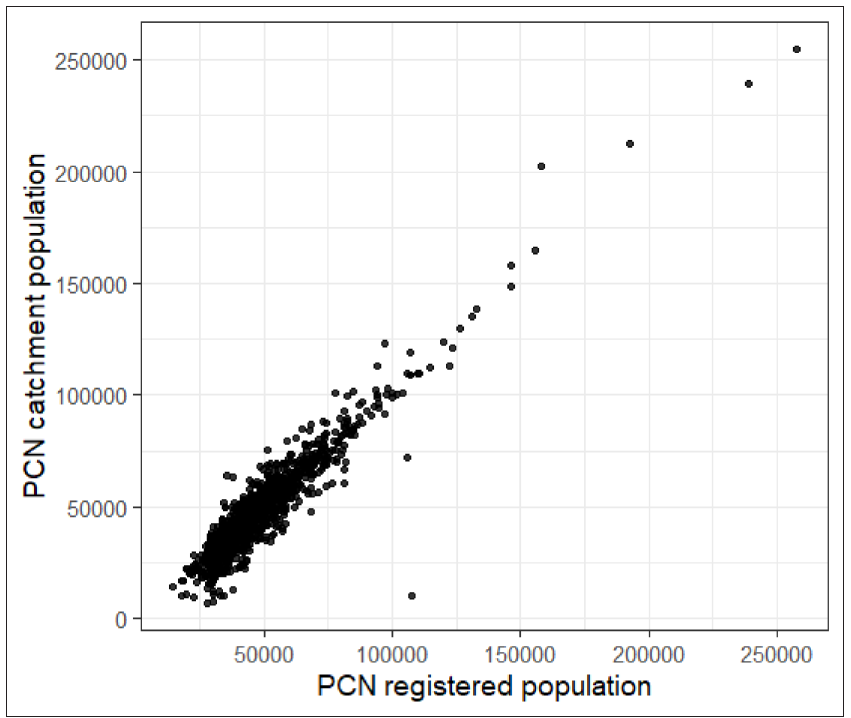
Figure 3 Total PCN catchment population against total PCN registered population for all PCNs in